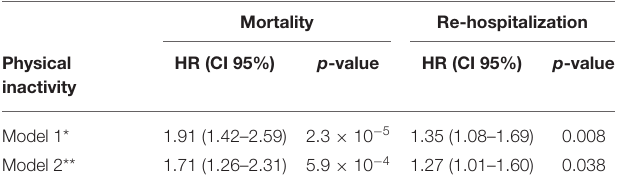
* Model 1: Adjusted for sex, age. ** Model 2: Adjusted for sex, age, body mass index, systolic blood pressure at admission, prevalence of chronic obstructive pulmonary disease, prevalence of diabetes, prior heart failure, education, brain atrial natriuretic peptide, acute admission, current smoking and prevalence of atrial